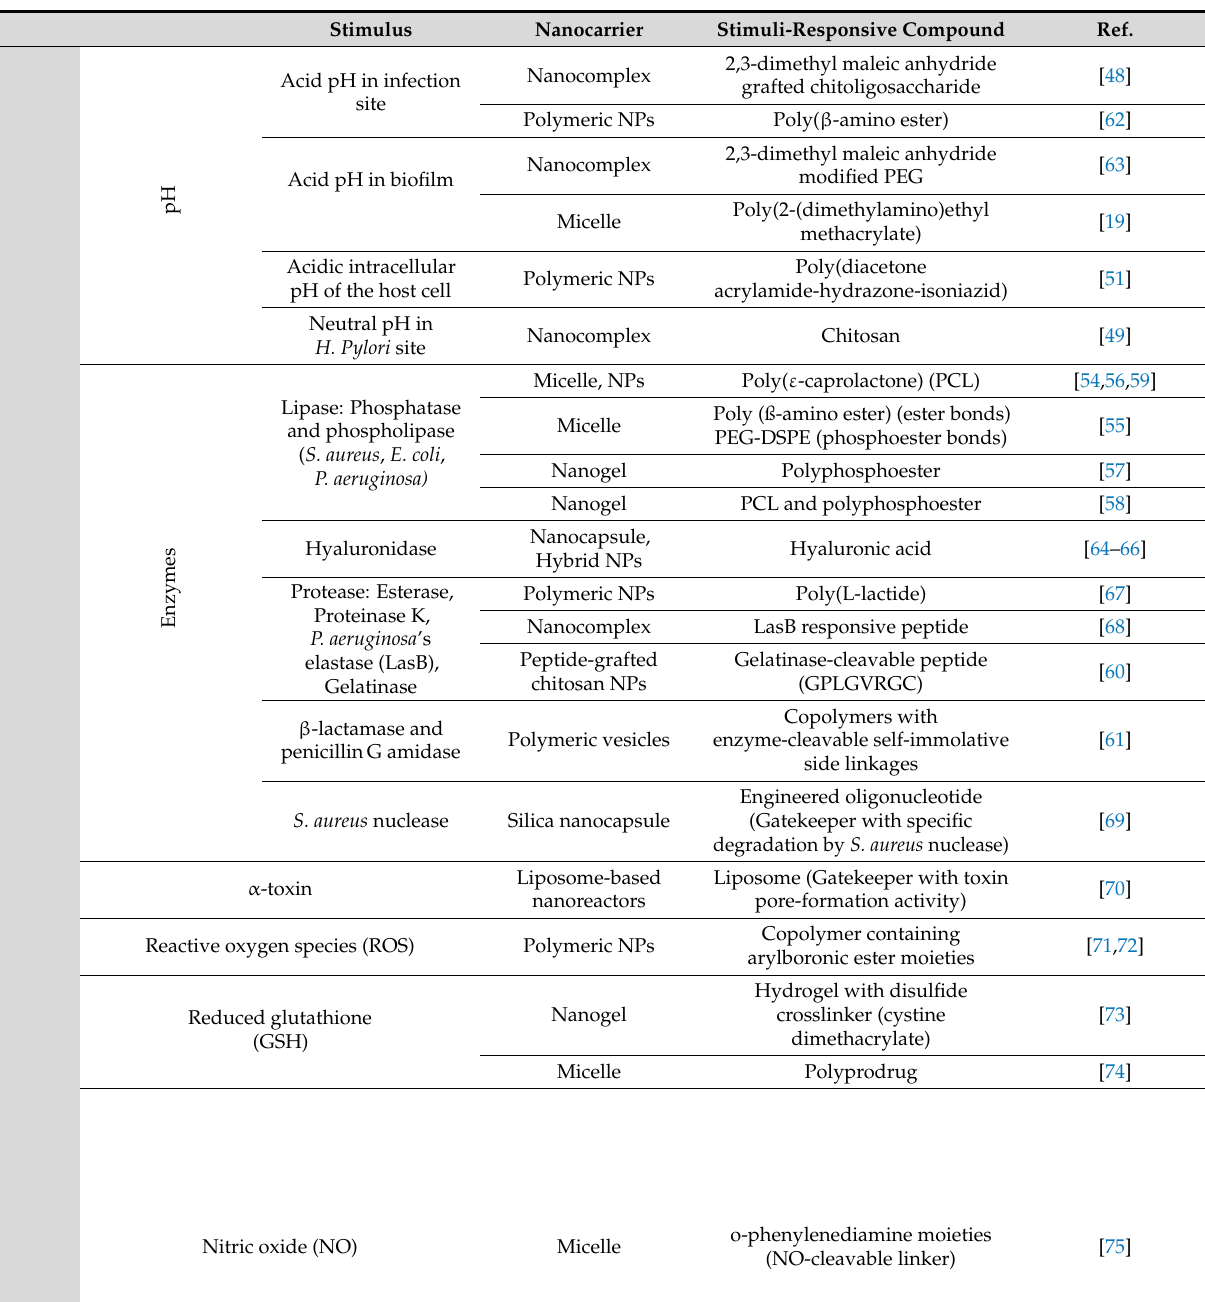
Table 2. Examples of stimuli-responsive nanocarriers for antibiotic